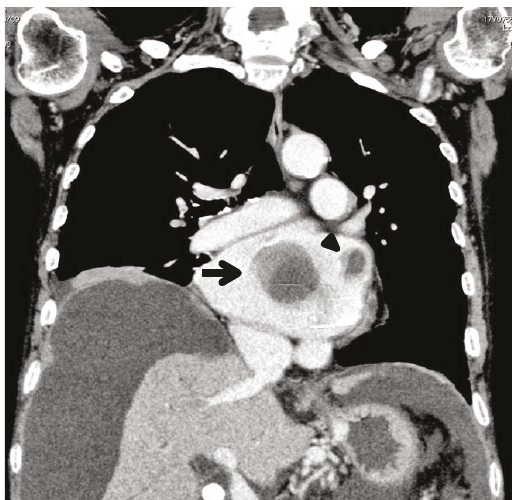
Figure 1: Computed tomography scan of the heart showing the free- fl oating ball-shaped thrombus (arrow) and appendage thrombus (arrow head). They look blurred due to movement within the left atrium.